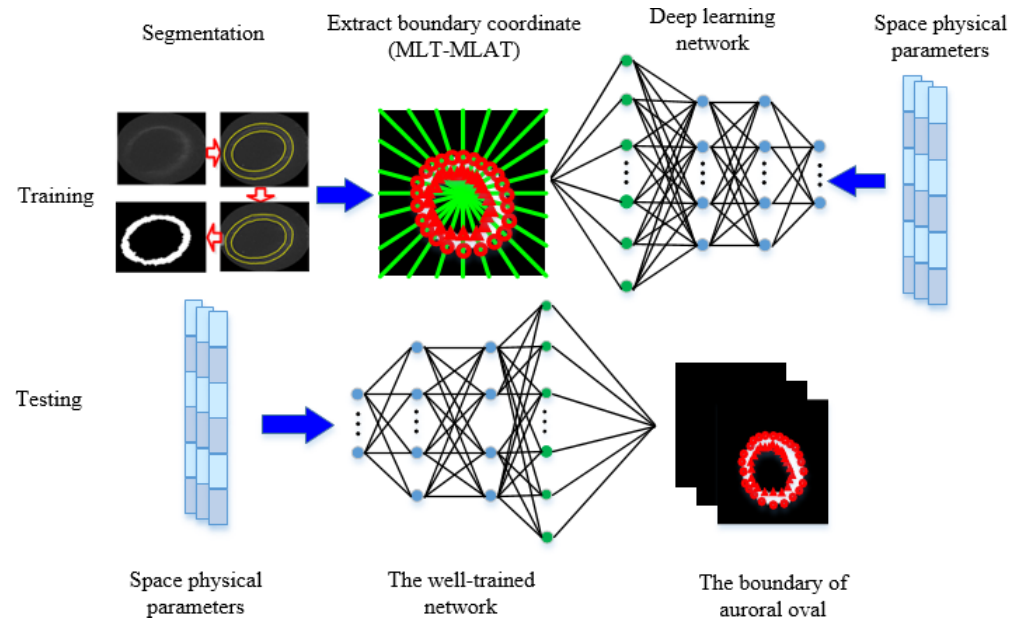
Figure 1. The flowchart of the auroral oval boundary prediction model based on deep